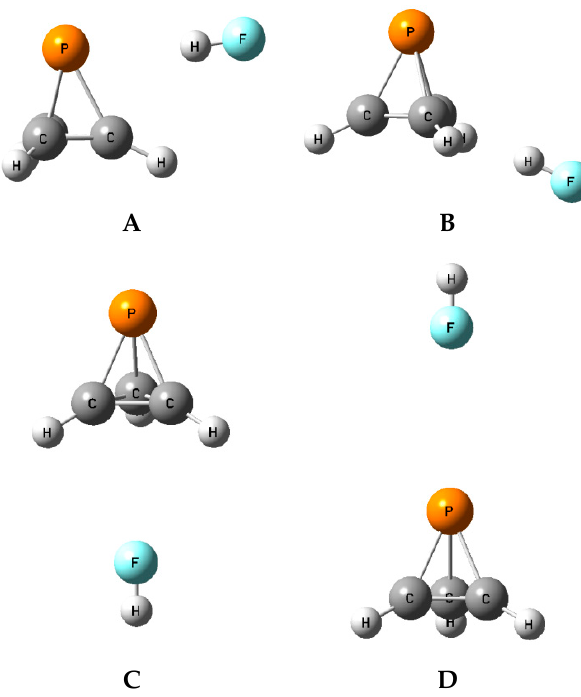
Figure 4. The equilibrium isomers A , B , C and D of FH:P(CH) 3 .